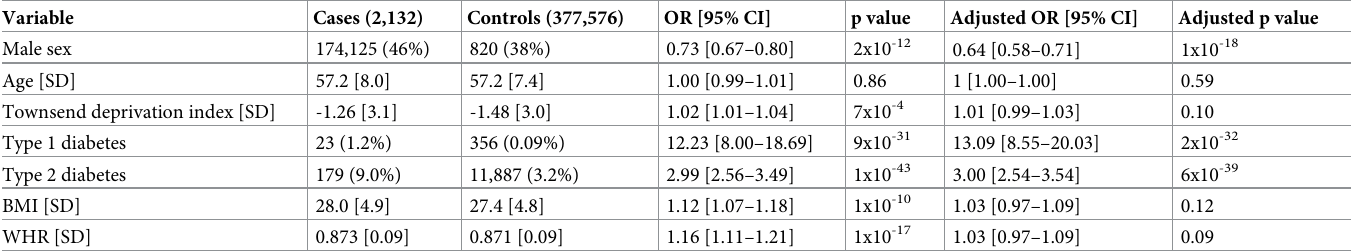
Table 1. Demographic and clinical associations with frozen shoulder in the UK Biobank. The OR and p value columns were calculated using univariable logistic regression. The adjusted OR and adjusted p value columns were calculated using a multivariable logistic regression model. Adjusted results for diabetes types were calcu- lated from a model excluding the other type. These analyses used only unrelated individuals in the UK Biobank.